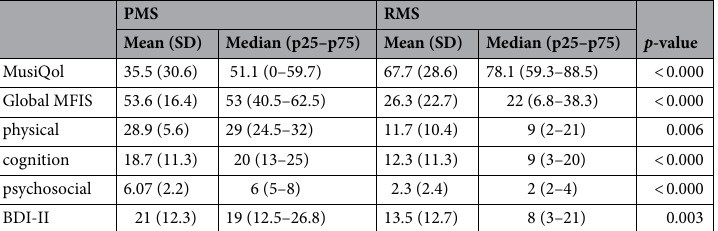
Table 2. Statistical differences between PRO scores from the pwPMS and pwRMS groups. PRO, Patient- reported outcomes; PMS, progressive multiple sclerosis; RMS, relapsing multiple sclerosis. MusiQoL, Multiple Sclerosis Quality Of Life; MFIS, Modified Fatigue Impact Scale; BDI-II, Beck Depression Inventory-II. The p -value was considered significant when <